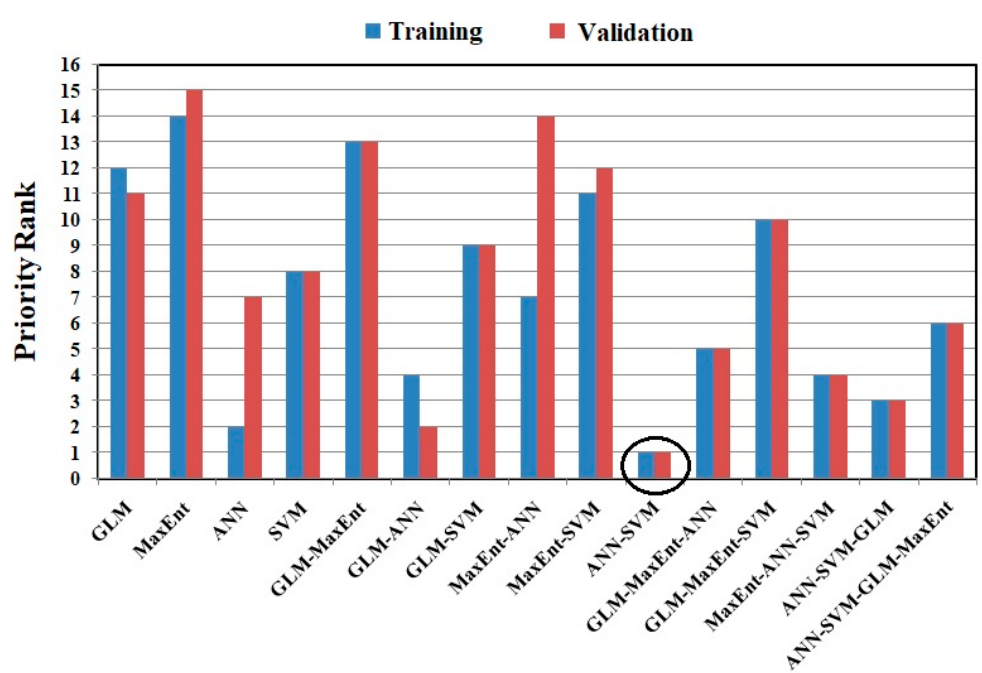
Figure 12. Prioritization of GESMs based on the AUC values of PRC and SRC.